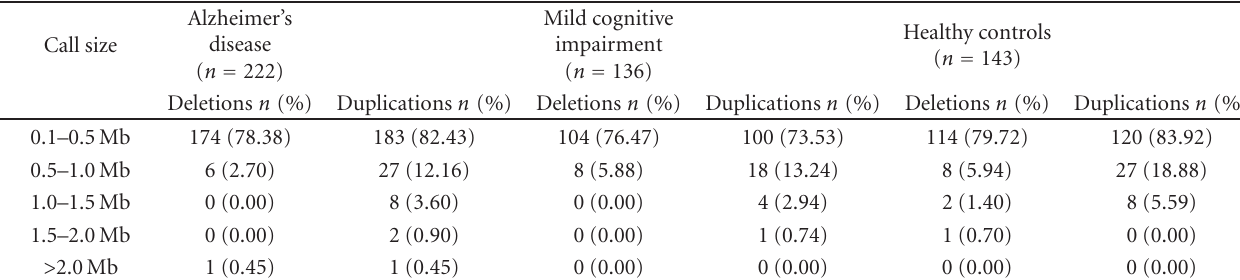
Table 3: Participants grouped by CNV call size.